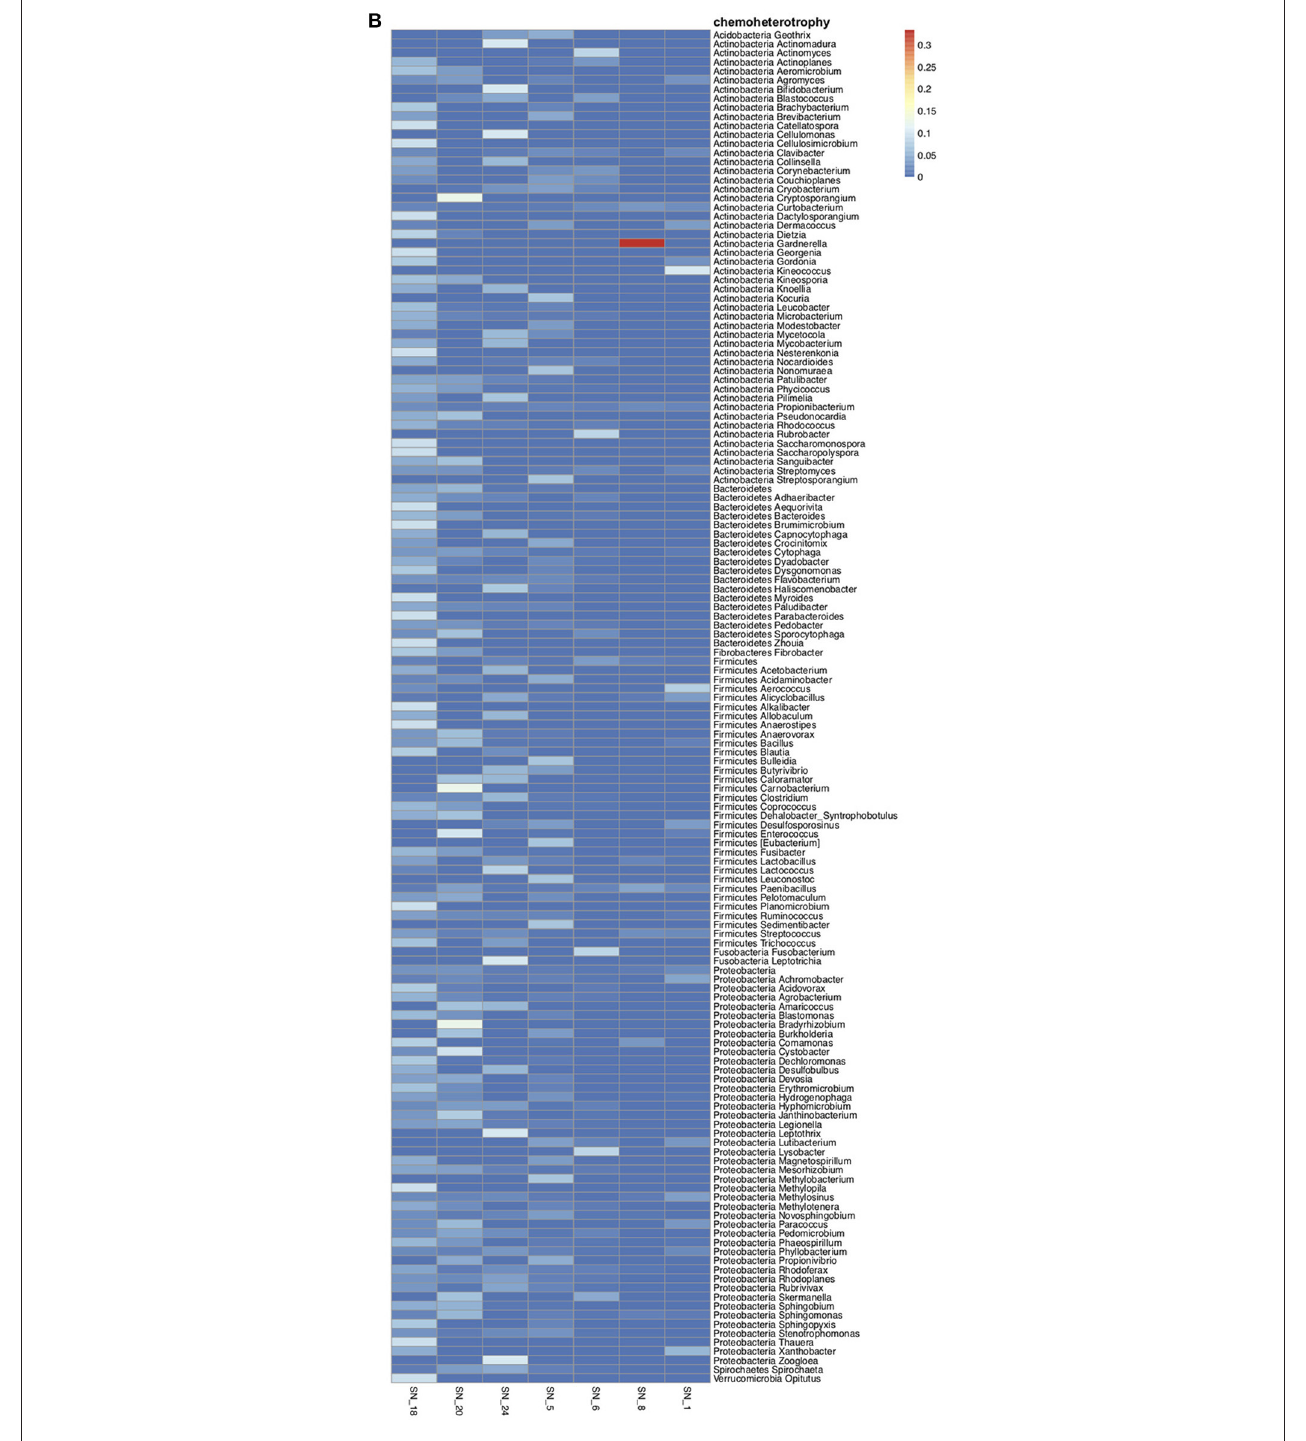
FIGURE 5 | (A) OTU richness in each functional group at the class level. The warmer color represents higher OTU numbers from a class contributed to a function. (B) The average relative abundance of chemoheterotrophic genera at each sampling site. The genera are grouped by the phyla they belong to. (C) The average relative abundance of OTUs belonging to methylotrophic